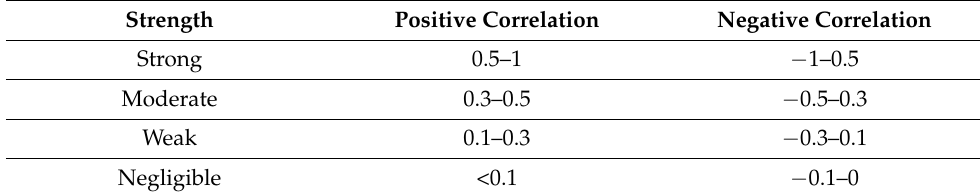
Table 5. The relationship strength according to the correlation coefficient.